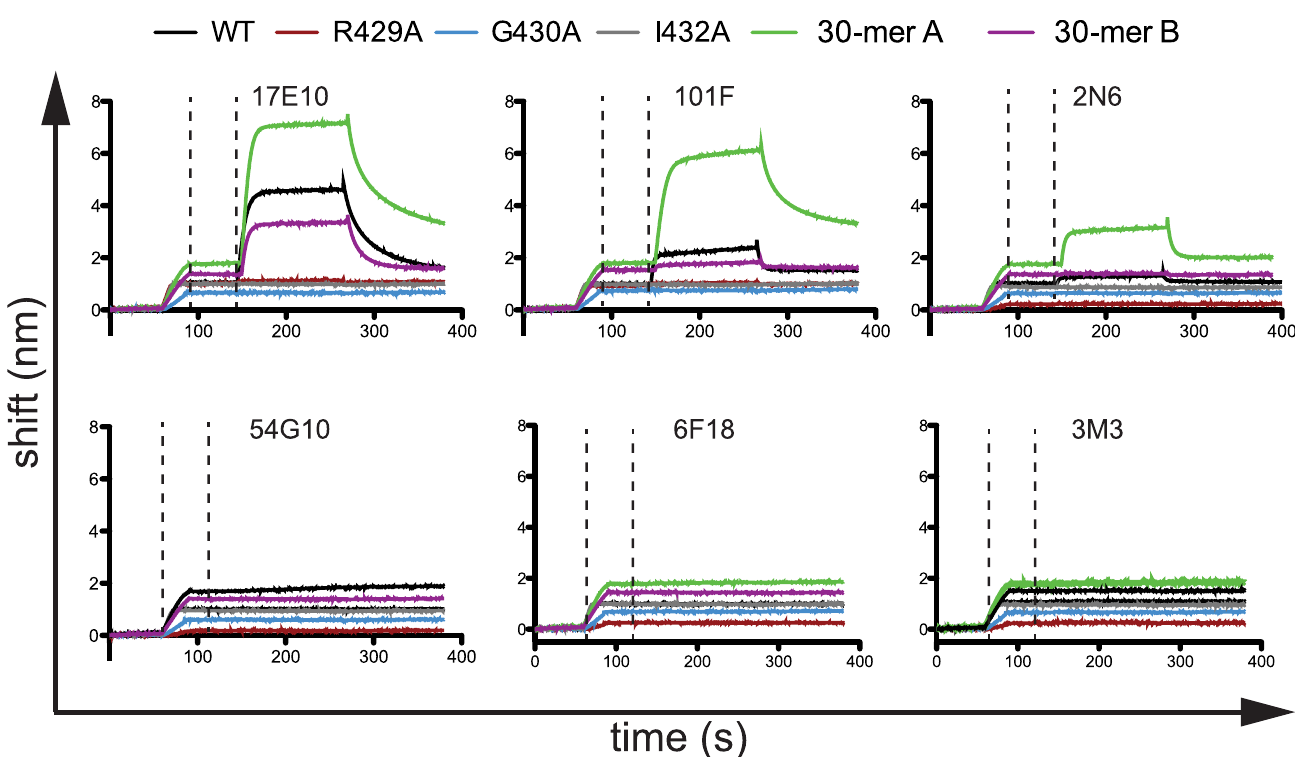
Fig 3. Binding curves determined by biolayer interferometry for mAbs targeting antigenic site IV. Streptavidin biosensors were incubated with biotinylated peptides, and then mAbs were tested for binding in real-time. The first dashed line indicates the end of the peptide loading step, and the second dashed line indicates the beginning of the mAb binding step. After binding, mAbs were allowed to dissociate in real-time. The data are representative chromatograms from one experiment. Wild-type (WT) and mutant peptides consist of RSV F residues 422–436. The 30-mer A peptide includes RSV F residues 407–436, and the 30-mer B peptide includes RSV F residues